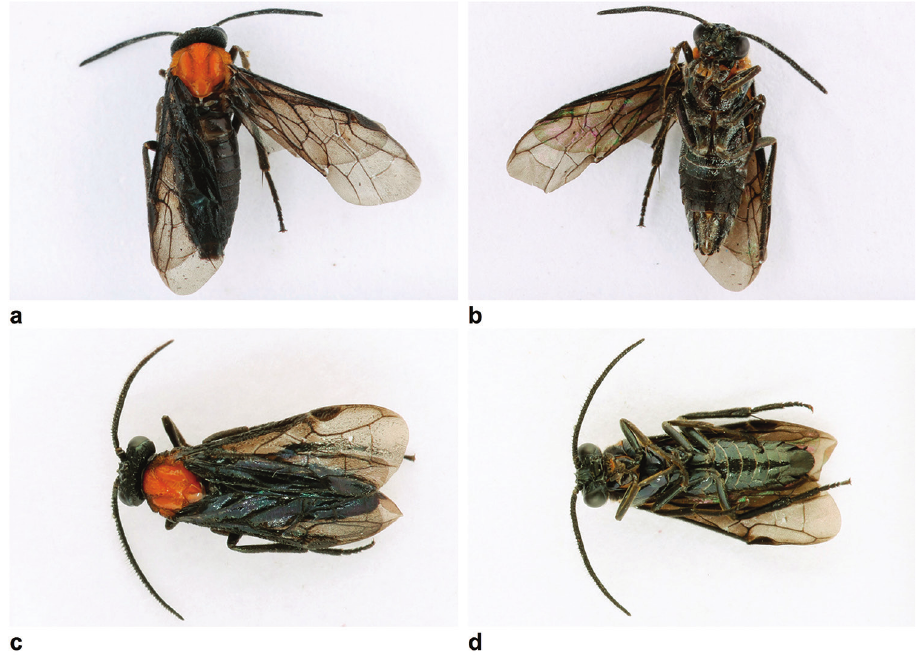
Figure 7. Scobina strophosa . a, b Female (P4238.A), body length 7.5 mm c, d male (P4241.B), body length 7.5 mm. a, c Dorsal views b, d ventral